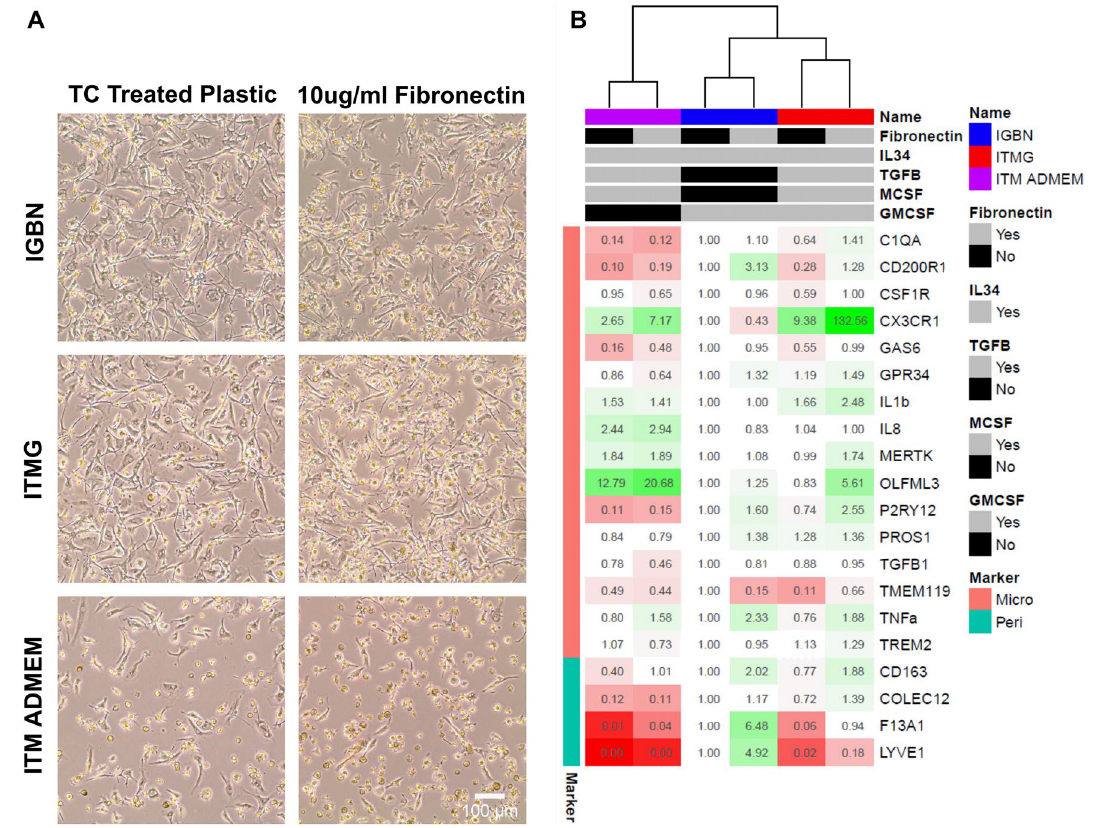
Figure 4. Low level supplementation with GM-CSF promotes cellular survival while maintaining microglial identity. ( A ) Morphology of microglia cultured for 14 days in three different media combinations on either tissue culture treated plastic or 10 µg/mL fibronectin. Each letter corresponds to a growth factor or compound; I IL-34, T TGF-β1, M M-CSF, G GM-CSF, B β-mercaptoethanol, N N-2 supplement. Phase contrast images taken at ×10 magnification, scale bar 100 µm. Media IGBN (Haenseler et al. 10 ) is the baseline for comparison. ITM ADMEM results in low survival and adherence on both TC treated plastic and 10 µg/mL fibronectin, however when supplemented with GM-CSF (ITMG) the survival and adherence is improved. ( B ) qPCR of the six samples from ( A ) for microglial and perivascular macrophage markers, fold changes represented as changes to IGBN TC treated plastic. Fold changes are presented as both colour changes (green indicates increased expression, red decrease expression) and the number within each cell. Samples cluster by medium followed by coating. ITMG promotes microglial identity with increased expression of CX3CR1 and OLFM3 and a reduction in perivascular macrophage markers ( LYVE1/F13A1) . Coating with fibronectin results in an increased expression of microglial identity genes in ITM and ITMG. Heatmap generated in R using the pheatmap